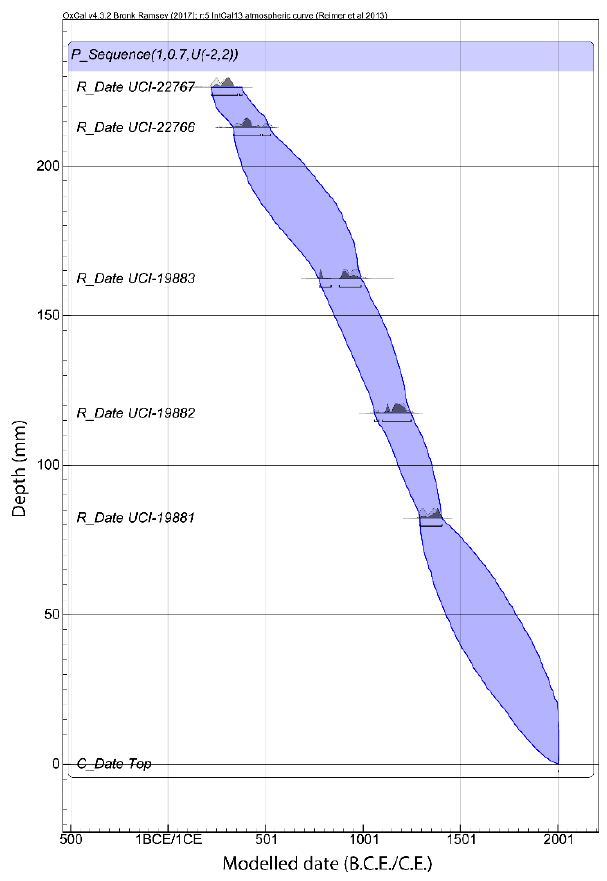
Figure 3. Age-depth model for El Gancho.